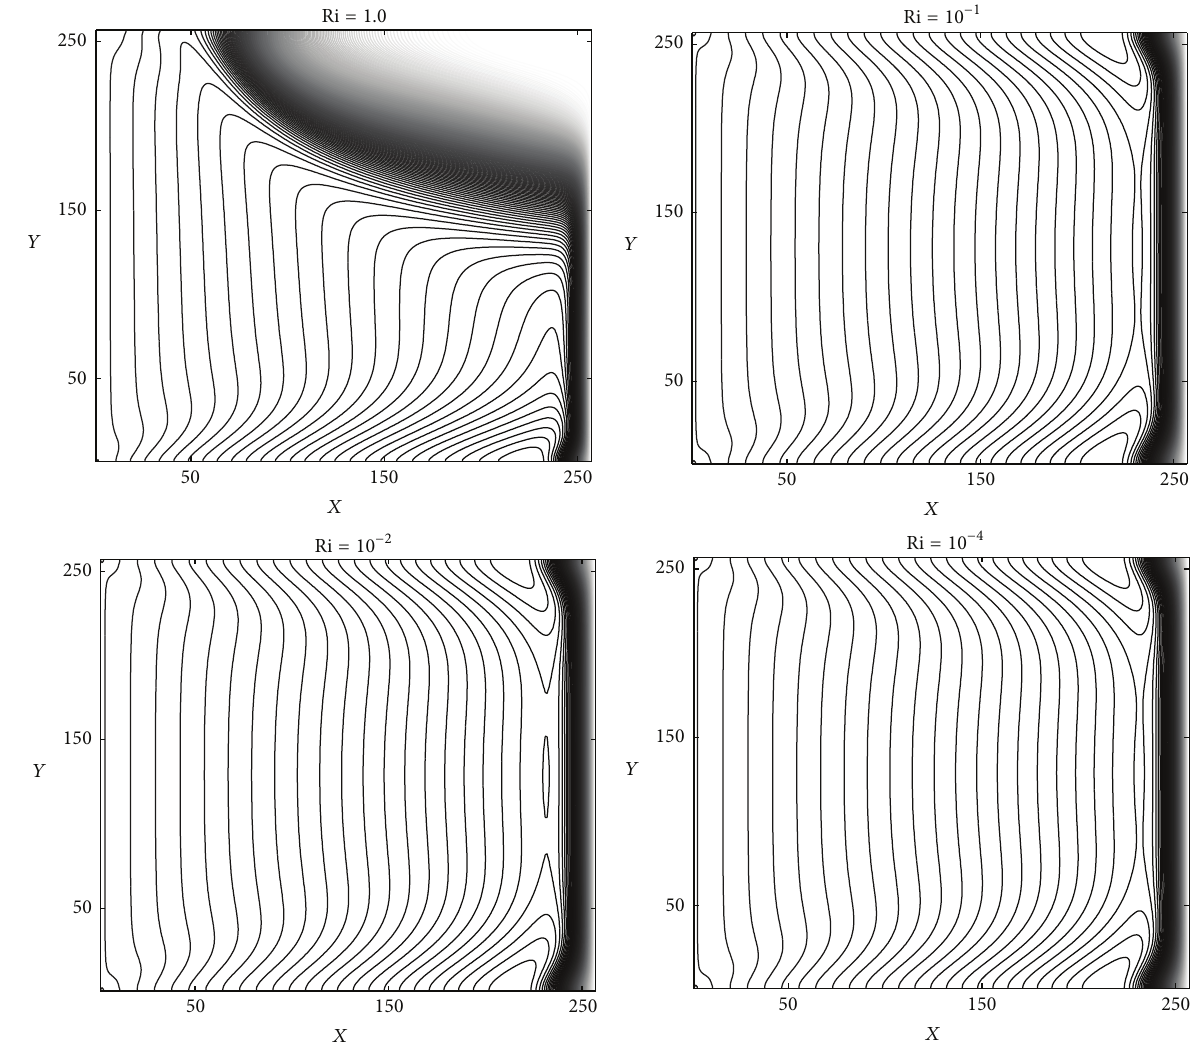
Figure 5: Isothermals for the Richardson numbers: Ri = 10 −4 , 10 −2 , 10 −1 , and 1.0.